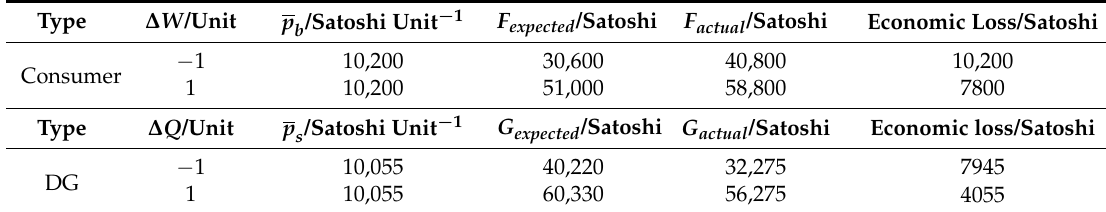
Table 2. Expected and actual cost or revenue of trading parties when prediction error is